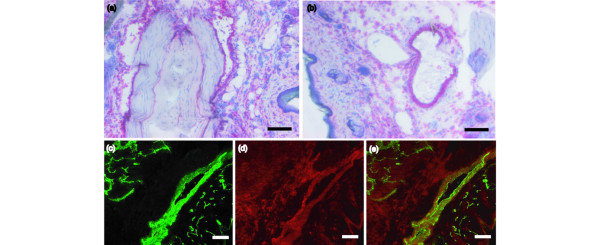
Histochemical analysis of arthritc paw sections. Immunohistochemistry with the small immunoprotein L19 on arthritic paw sections reveals expression of extra domain B of fibronectin (EDB) in the tunica synovialis and inflammatory infiltrates (a) and (b). An immunofluorescent co-staining shows co-localisation of CD31 (green) and EDB (red) surrounding vascular structures (c)–(e). Scale bars = 100 μm.